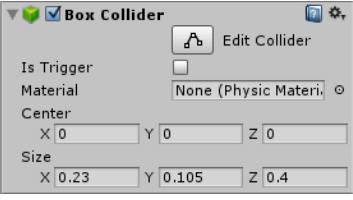
Figure 26. Box Collider component.